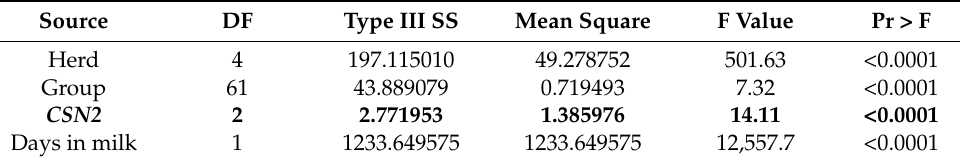
Table 13. Linear model (dependent variable: protein%).